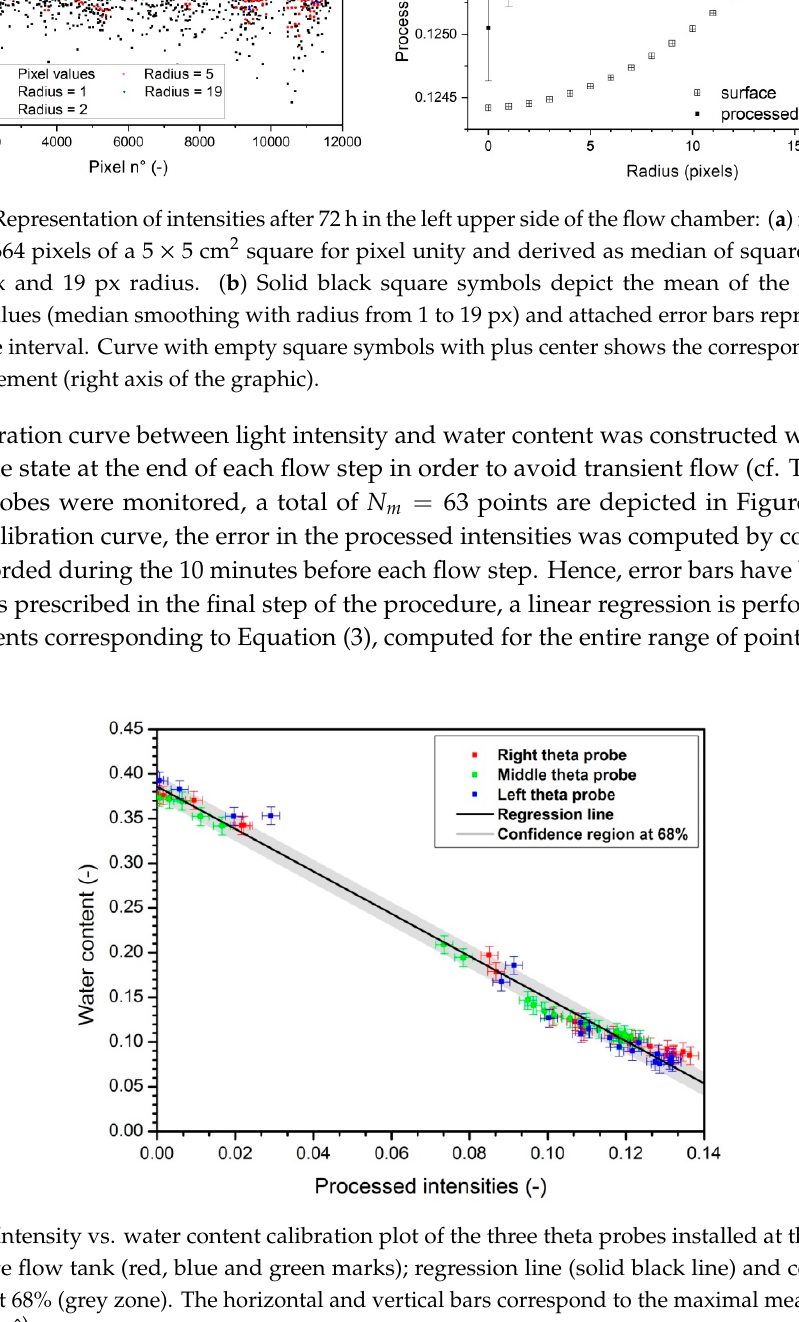
Figure 5. Intensity vs. water content calibration plot of the three theta probes installed at the surface of the large flow tank (red, blue and green marks); regression line (solid black line) and confidence intervals at 68% (grey zone). The horizontal and vertical bars correspond to the maximal measurement error on I θ estimated to ± one standard deviation.